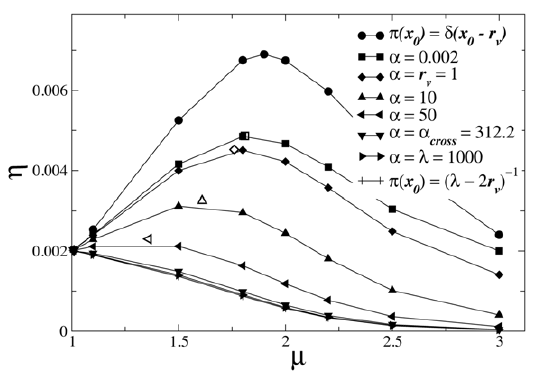
Figure 1. Robustness of the ballistic optimal search strategy with respect to fluctuations in the distances to faraway target sites. In the case of Le´vy random searchers, for l ~ 10 3 and r v ~ 1 , the average search efficiency g , Eq. (5), is always highest for m ? 1 (ballistic dynamics), for any value of the parameter a of the Poissonian fluctuations around the maximum allowed distance, x 0 ~ l = 2 , Eq. (2). Cases with uniform and without any ( d -function) fluctuation are also shown. Solid lines are a visual guide.